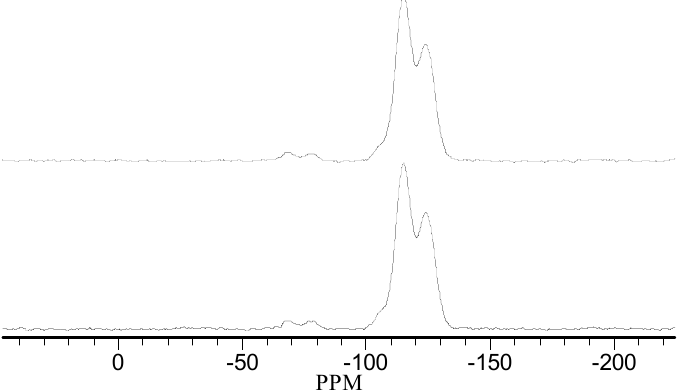
Figure 5. 29 Si solid-state NMR spectra of the fluorine-modified colloidal silica and unmodified silica (particle size: 340 nm).